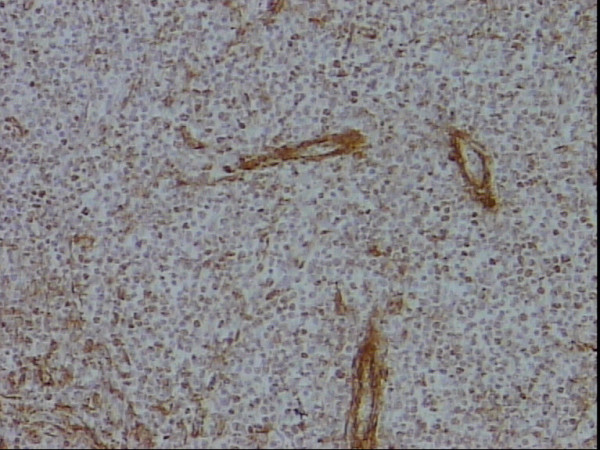
SMA staining showing positivity of the lymphocytes and internal control of the blood vessels, DAB, Hx, × 10.